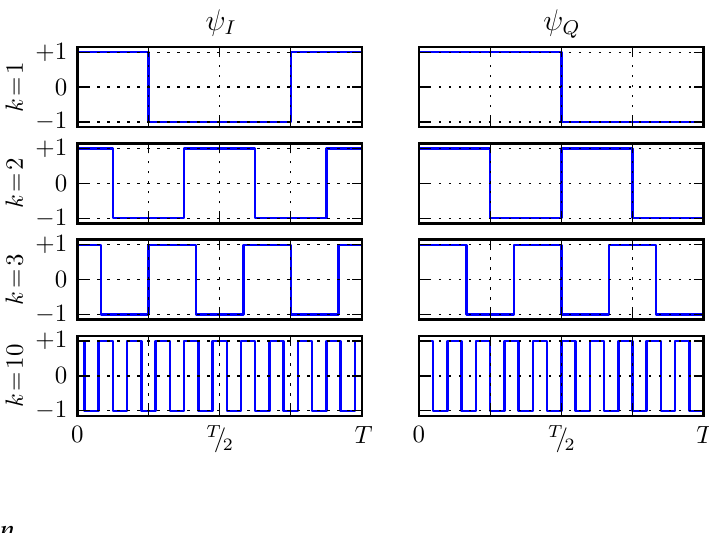
Figure 3. Quadrature basis function waveforms for k =1 , 2 , 3 , 10